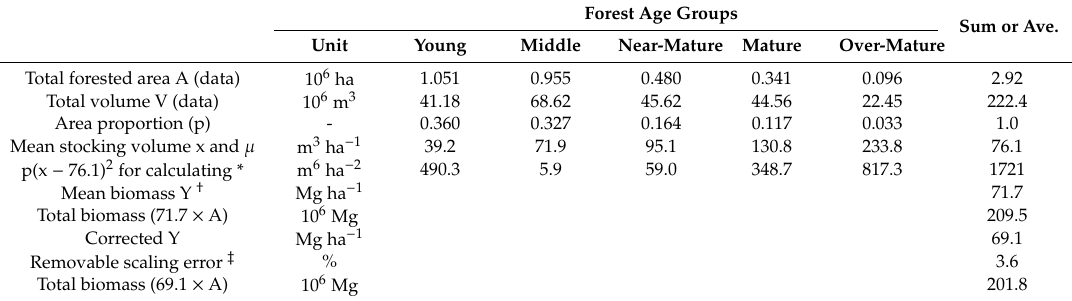
* Variance is calculated based on stocking volume of each age group (data of A and V refer to the reference [38]). † Biomass density is calculated using y = r x k e u x ; parameters refer to the caption of Figure 3. ‡ Scaling error is calculated based on Equation